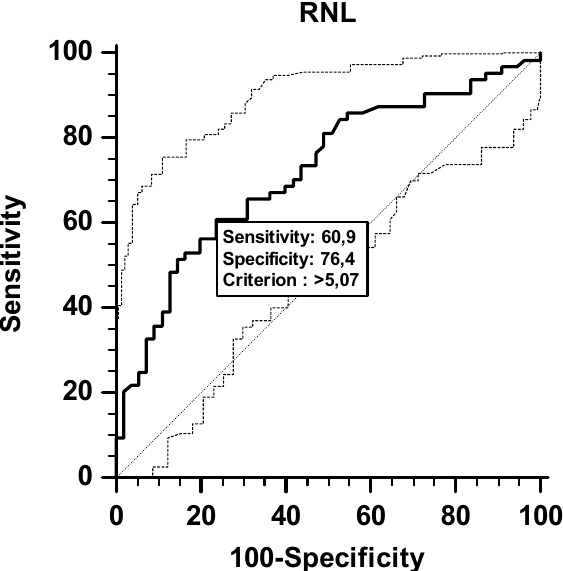
Figure 1. Receiver operating characteristic (ROC) curve, confidence interval, cut-off point, sensitivity, specificity, predictive value for the best cut-off point of the NLR value to discriminate nutrition risk (NRS, 2002) in hospitalized cancer patients. NLR: neutrophil–lymphocyte rate.